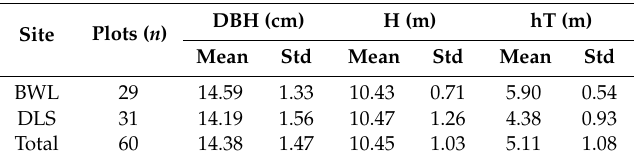
Table 1. Summary of the field